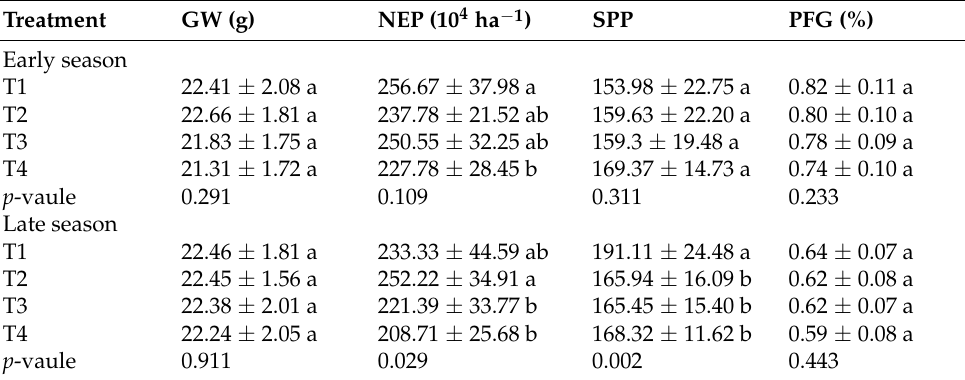
Table 2. Effects of different seedling numbers per hill and row spacing on rice yield